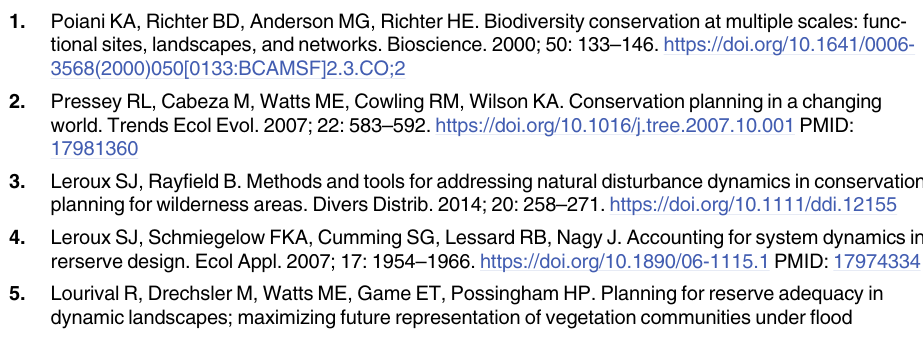
S3 Table. Spruce budworm-based MDR simulation results using a 2km 2 minimum thresh- old. Reserve size: the area of the MDR being tested. Initial area: the amount of each age class in the reserve. Minimum area: the lowest value recorded for each age class throughout all 100 simulations. Also shown are the mean and standard deviation across all 100 simulations. In order to pass the simulation evaluation, all three age classes had to be maintained above a 2km 2 threshold. S4 Table. Protected area simulation results. Only protected areas that met the MDR size and requirements, and had full coverage of forest inventory data were evaluated. Reserve size: y SBW the area of the MDR being tested. Initial area: the amount of each age class in the reserve. Min- imum area: the lowest value recorded for each age class throughout all 100 simulations. Also shown are the mean and standard deviation across all 100 simulations. In order to pass the simulation evaluation, all three age classes had to be maintained above a 1km 2